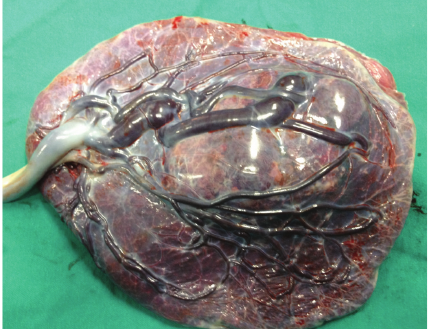
Figure 4: The photograph of the maternal surface of the placenta. The typical localization of the tumor is seen near the umbilical cord